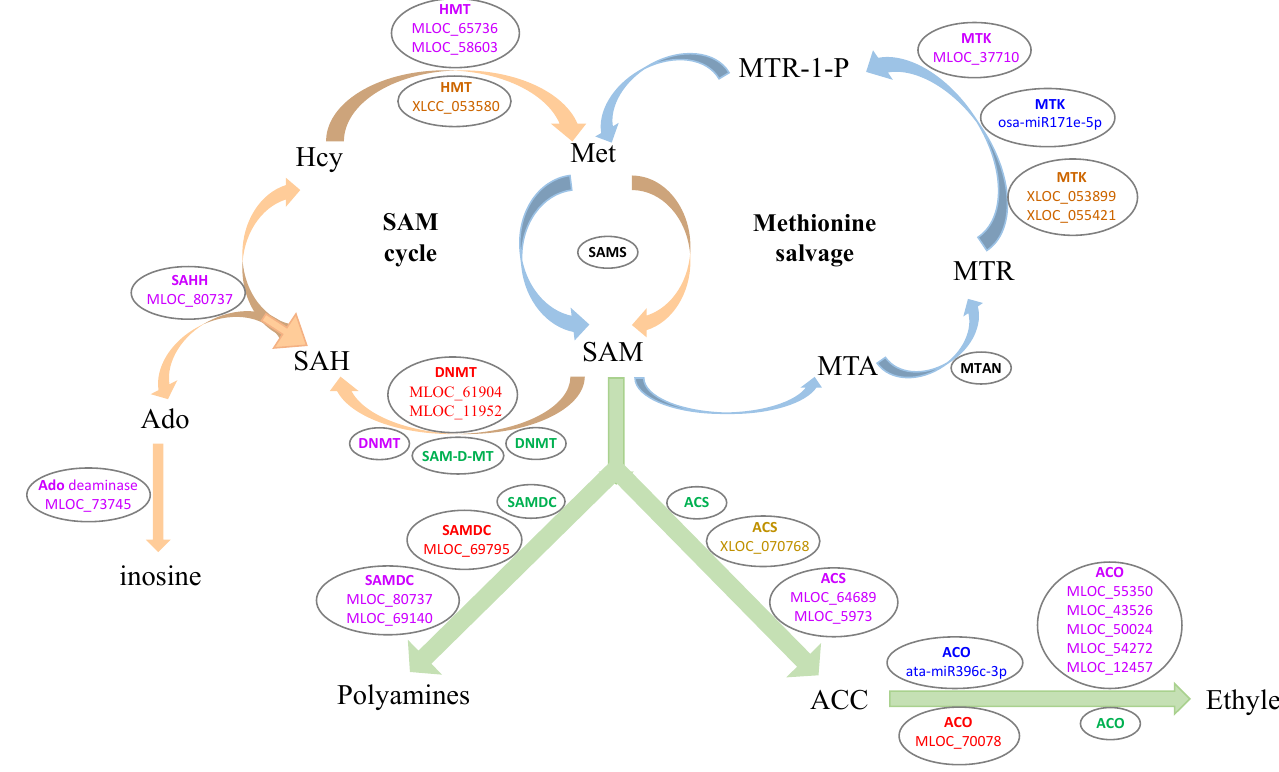
Figure 5. Pathways highlighting the involvement of SAM and methionine involving in ethylene